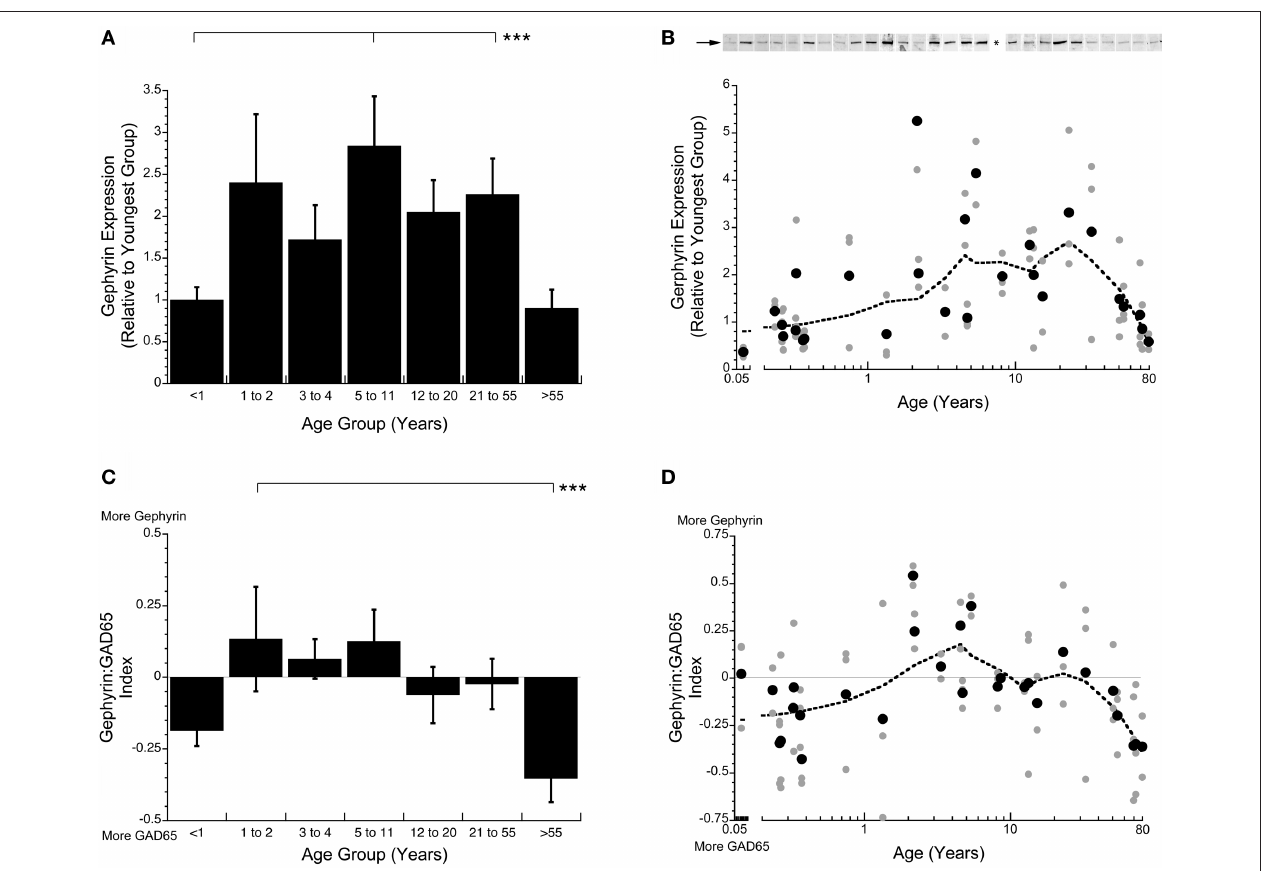
children (1–11 years) to a balance from the teenage to adult years (12–55) then a switch to much more GAD65 in aging ( > 55 years) (Kruskal–Wallis, p < 0.008) (C) . The lines above the histograms identify the groups that were significantly different (Tukey’s post hoc HSD, * p < 0.05, ** p < 0.02, *** p < 0.001) (• average expression for each case; • all runs; dotted line is the weighted